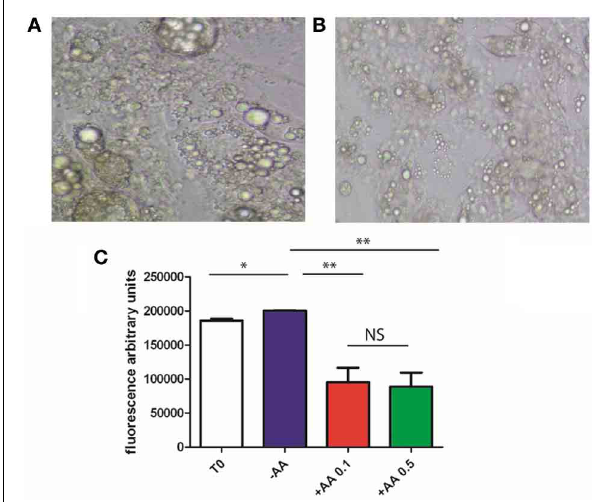
FIGURE 4 | 3T3L1 and dedifferentiation. Cells were cultured during 7 days with IBMX, allowing full differentiation. Medium is discarded and replaced with a medium without IBMX either not supplemented (A) or supplemented with 0.1mM AA or 0.5mM (B) . After 9 days, AdipoRed was added and fluorescence recorded (for details see Materials and Methods), (C) . Results are expressed in fluorescence arbitrary units. ∗ p < 0 . 05, ∗∗ p < 0 . 01.